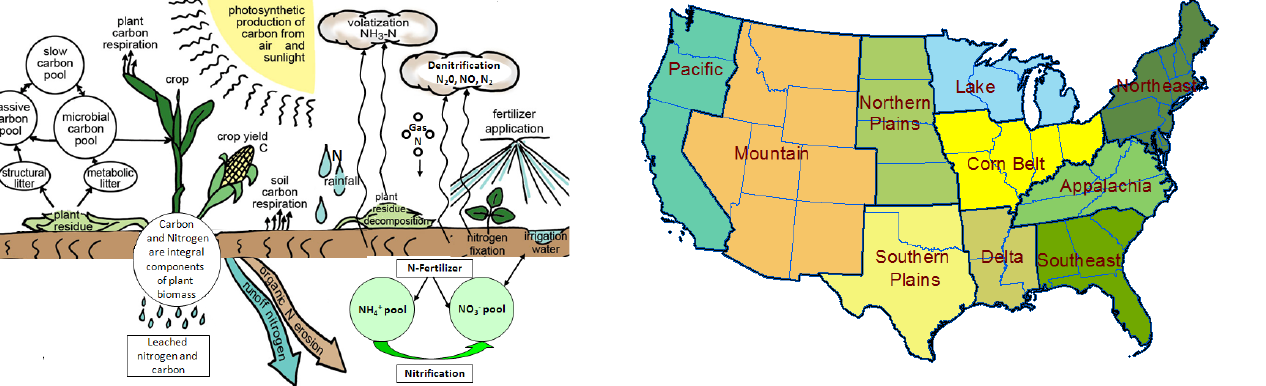
Fig. 1. Biogeochemical components of the carbon and nitrogen bud- gets in EPIC.